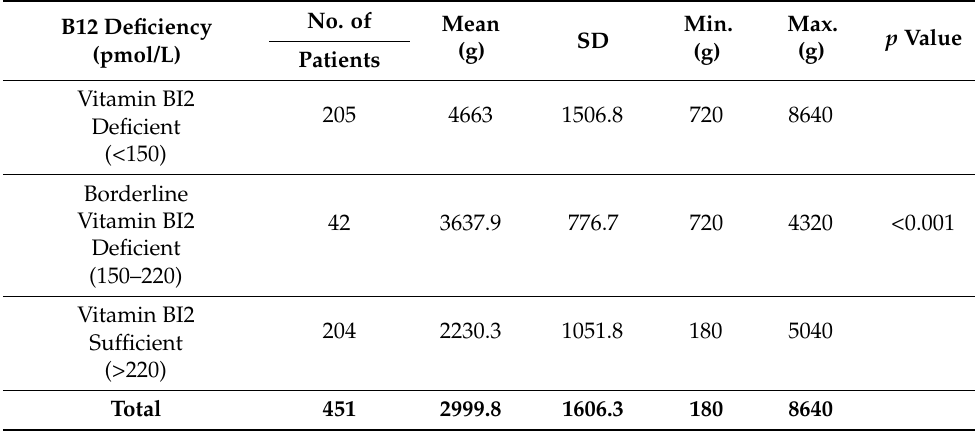
Table 2. Relationship between cumulative dose of metformin (grams {g}) and Vit B12 (pmol/L)